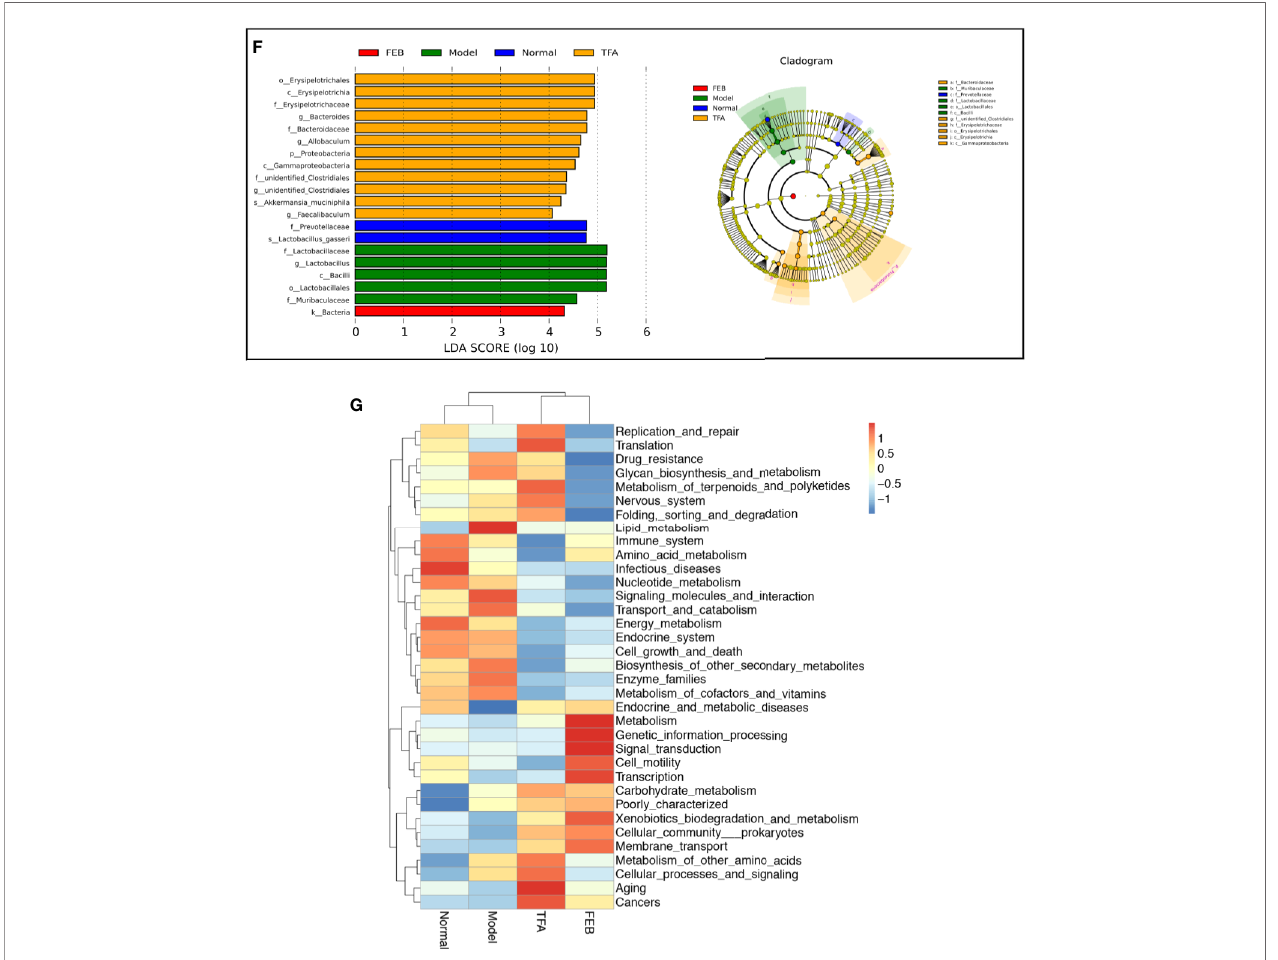
FIGURE 2 | Effects of TFA and FEB on gut microbiota dysbiosis. (A) Changes in the relative abundance of gut microbiota at the order level in the four rat groups. (B) NMDS analysis for the relative abundance of bacterial OTU in the four rat groups. (C) Unweighted unifrac b -diversity of bacterial community. (D) ANOSIM analysis of categorical variables between the Normal and Model groups, Model and TFA groups, and Model and FEB groups. (E) MetaStat analysis for the relative abundance of signi fi cantly altered bacterial taxa at the family and genus levels in the four rat groups. (F) LEfSe for the signi fi cant bacterial taxa with LDA scores > 4.0 in the four rat groups. Differences are represented by the color of over-represented taxa: blue indicating the Normal group; green indicating the Model group; yellow indicating the TFA group; and red indicating the FEB group. Circles represent phylogenetic levels from phylum (innermost circle) to genera (outermost circle). (G) Predicted microbial functions using Tax4Fun in the four rat groups. The data are expressed as the mean ± SD, (n = 3). * P < 0.05, ** P < 0.01. TFA, total fl avones of Abelmoschus manihot ; FEB, febuxostat; NMDS, non-metric multi-dimensional scaling; OTU, operational taxonomic unit; ANOSIM, analysis of similarities; LDA, linear discriminant analysis; LEfSe, linear discriminant analysis effect size; SD, standard